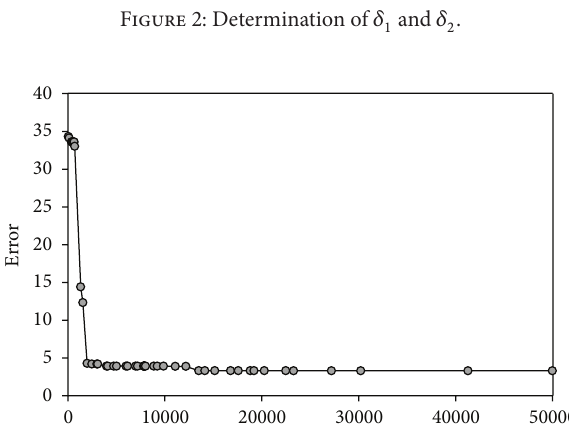
Figure 5: Comparison between test data and predicted